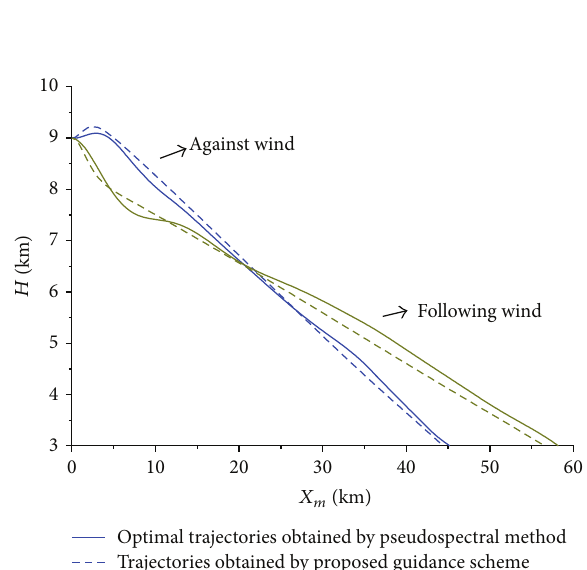
Figure 10: Gliding trajectories with wind